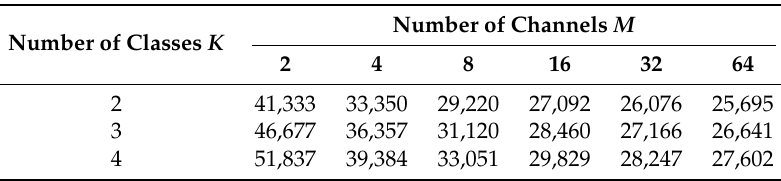
Table 4. The normalized area per channel ( µ m 2 /channel) of the proposed circuit for different numbers of channels M and classes K .